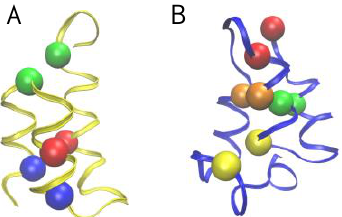
Figure 2. Comparison of the Cys-Cys bond patterns in the native E r -1 ( A ) and E n -1 ( B ) pheromone structures. Spheres of identical color indicate cysteine residues paired together into a disulfide